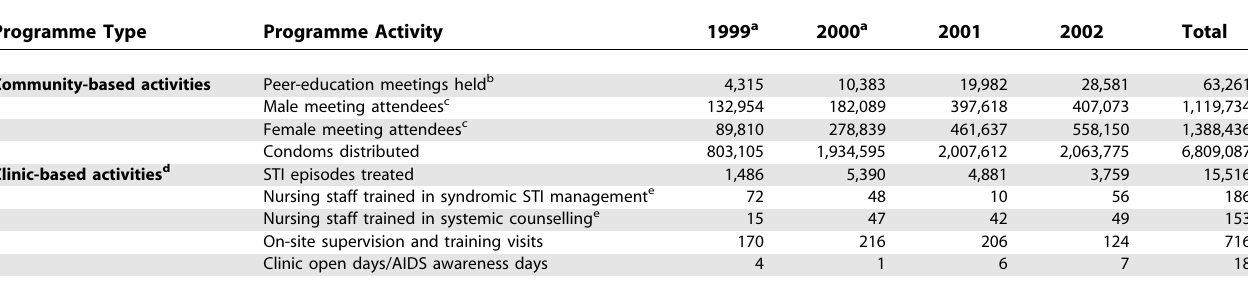
Table 4. Summary of Service Statistics on Programme Output Programme